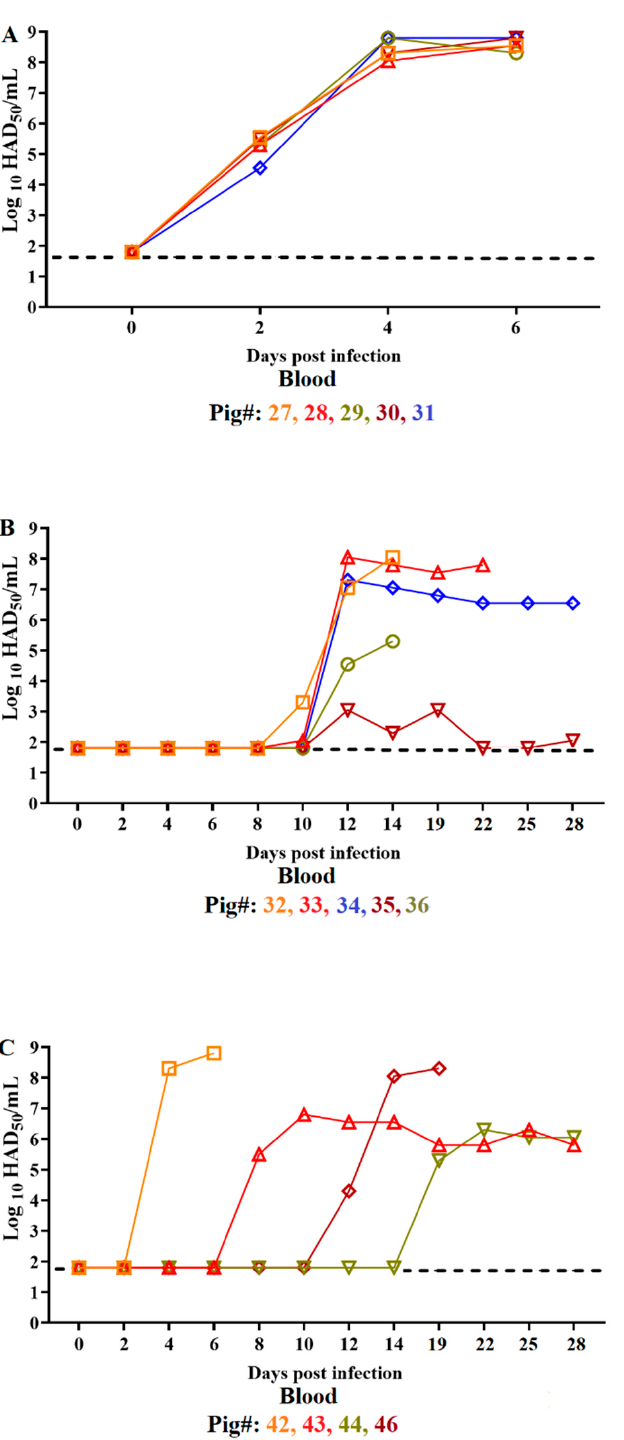
Figure 3. Virus titers in blood collected from animals inoculated with ASFV-DR21 IM ( A ), by contact ( B ), or ON ( C ) from day 1–28 pi. Data are presented as individual values of virus titers (expressed as HAD 50 /mL), with different colored lines and symbols representing individual animals. Sensitivity of detection ≥ 1.8 log 10 /mL. Animal #45 was excluded from the data presented due to removal from the study on day 0.